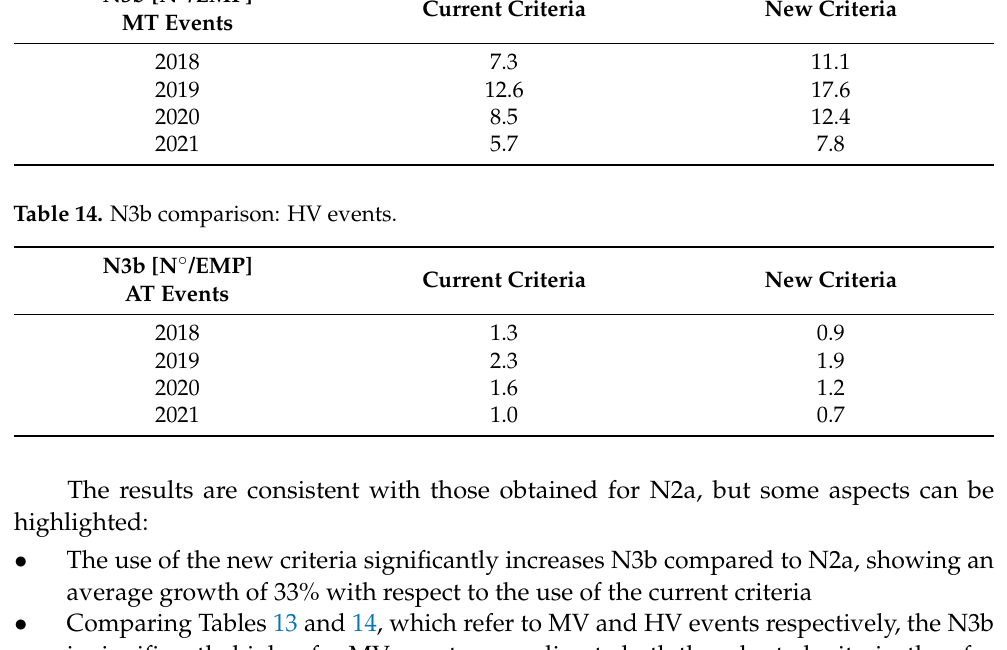
Table 13. N3b comparison: MV events.